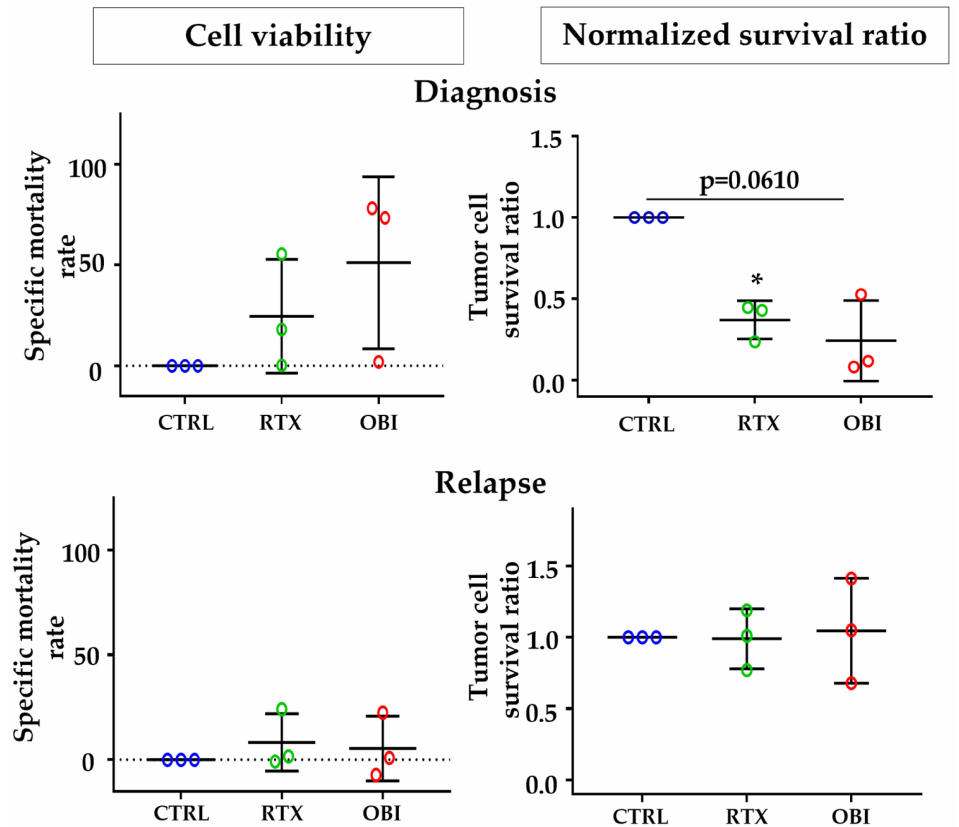
Figure 7. Tumor B cells from NHL and B-CLL patients at relapse are resistant to CD20 mAb-induced direct cell death. PBMCs from patients at diagnosis (top graphs) and after relapse (bottom graphs) were treated for 8 h with the depicted mAbs, and tumor B cell death was examined by the method of cell viability (left) or normalized survival ratio (right) described in Figure S5. Each point represents results for one patient at one time point (diagnosis or relapse) and was performed in duplicate. Graphs show mean +/ − SD of 3 experiments; * p < 0.05; Tukey’s multiple comparisons test compared to control or as depicted in the